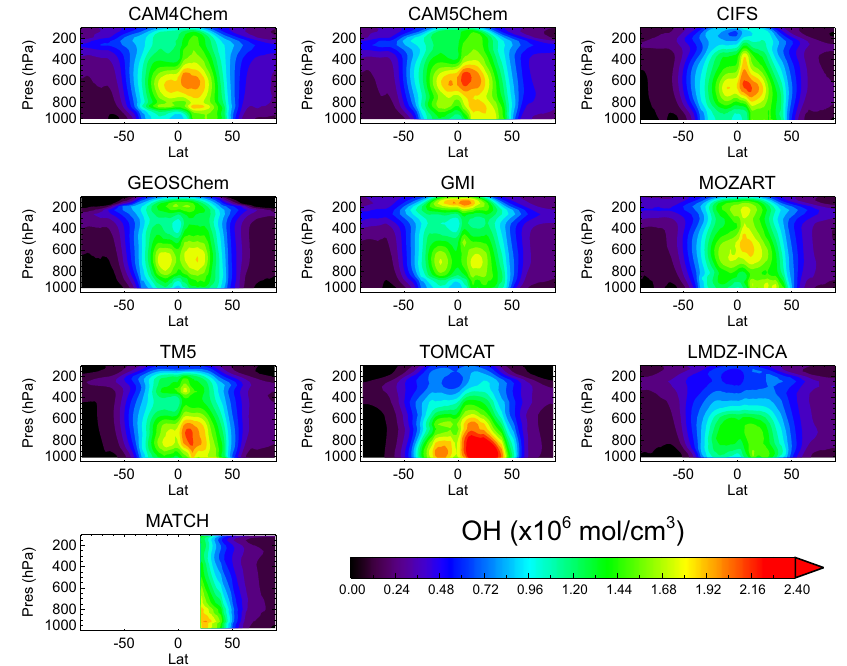
Figure 11. Annual zonal mean OH concentrations ( × 10 6 moleculescm − 3 ) for 2008 from the POLMIP models.